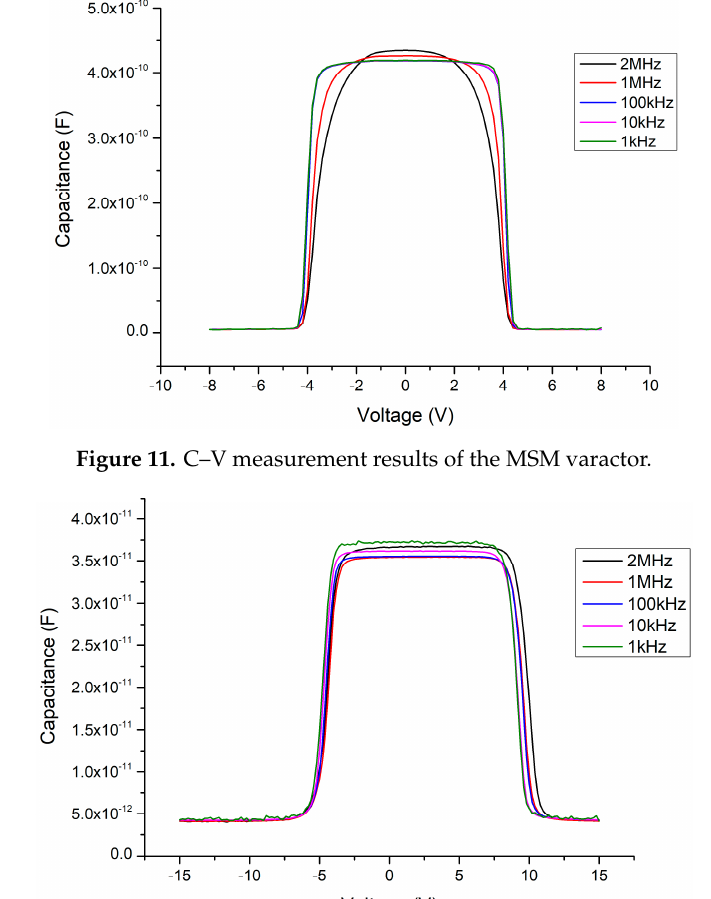
Figure 12. C–V measurement results of the MOSOM varactor (with a 341 nm thick Ga 2 O 3 thin film) from − 15 to + 15 V.